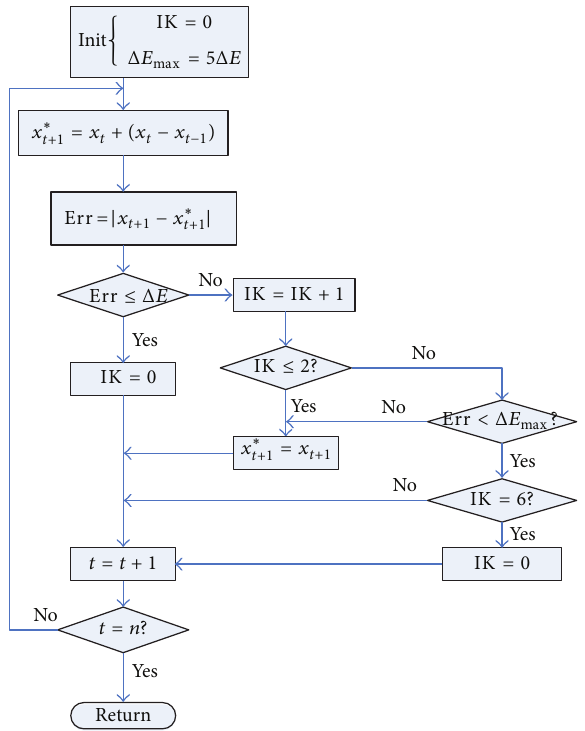
Figure 3: Process of detecting